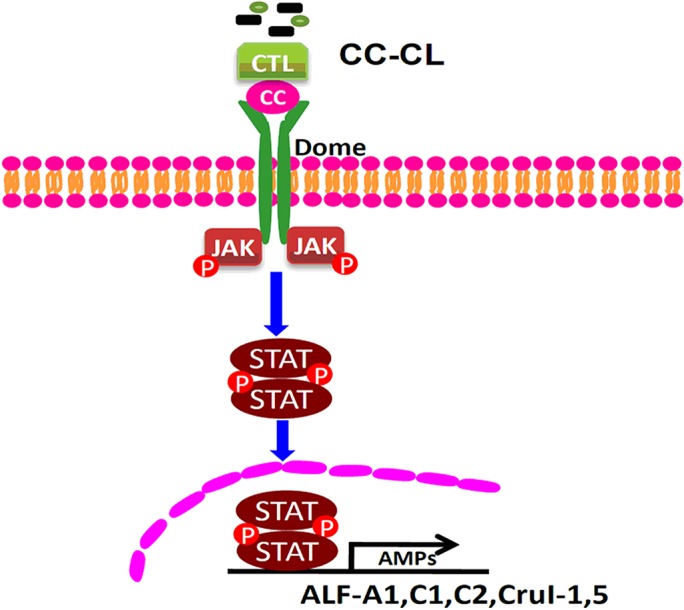
MjCC-CL directly activates the JAK/STAT signaling pathway to regulate AMP expression.The CTL domain of MjCC-CL recognizes different bacteria, and the CCD of MjCC-CL interacts with the ILR domain of the Dome receptor. The transcription factor STAT is phosphorylated and translocates into the nucleus, inducing the AMP expression. JAK/STAT pathway activation is responsible for the clearance of invading bacterial pathogens by regulating AMP expression.